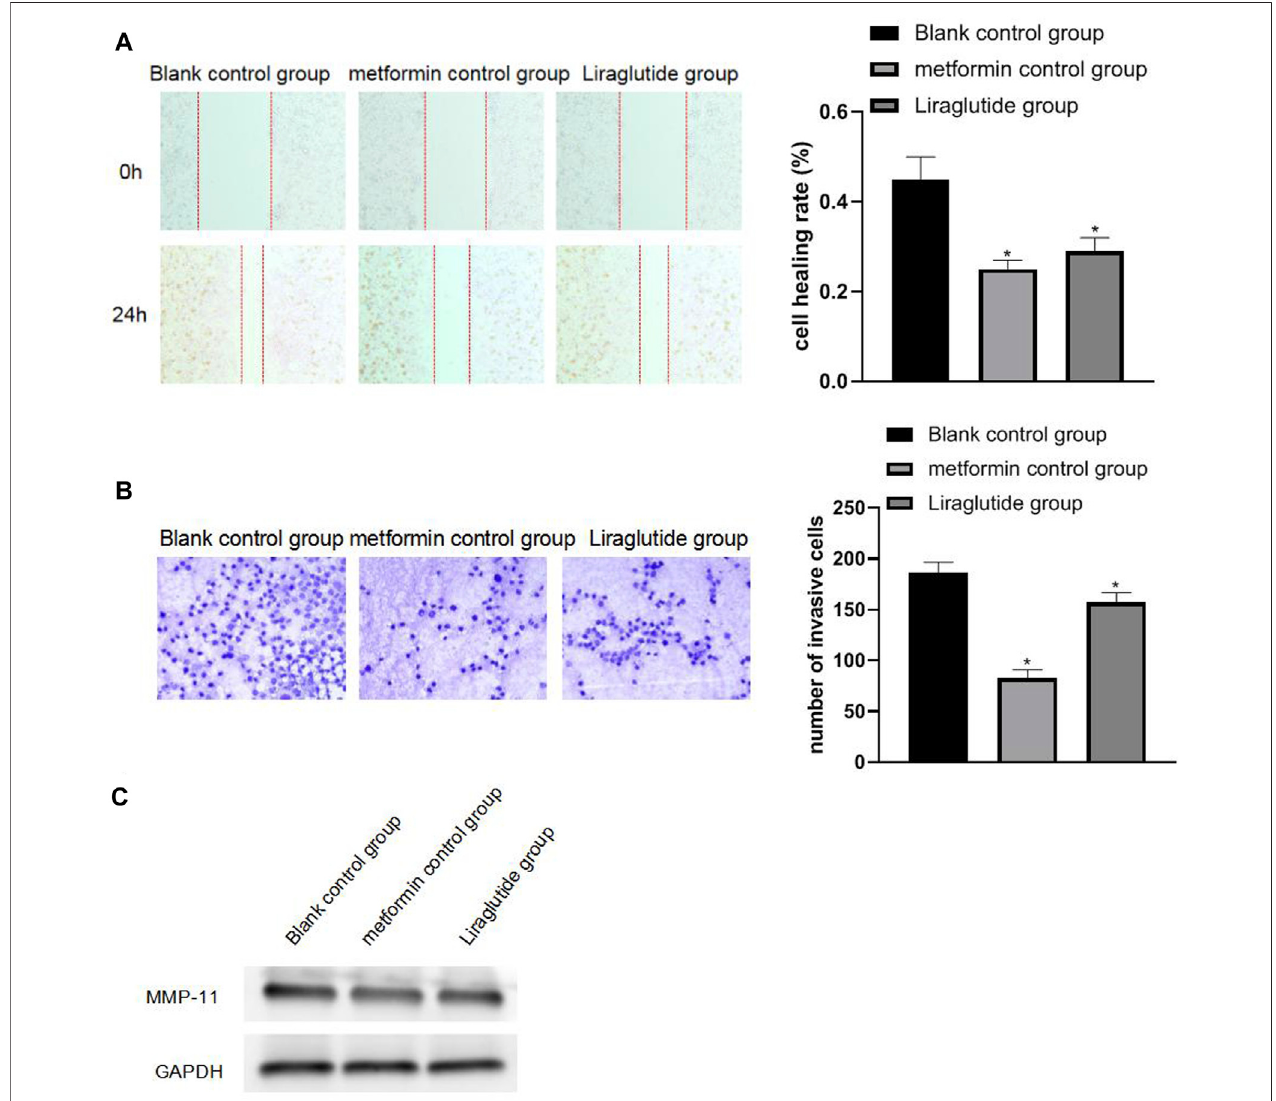
FIGURE 3 | Effects of GLP-1 receptor agonists on the migration and invasiveness of CRC cells. Note: (A) wound healing experiment; (B) Transwell experiment (20 × ); (C) Western blotting experiment, compared with blank control group, * p < 0.05.